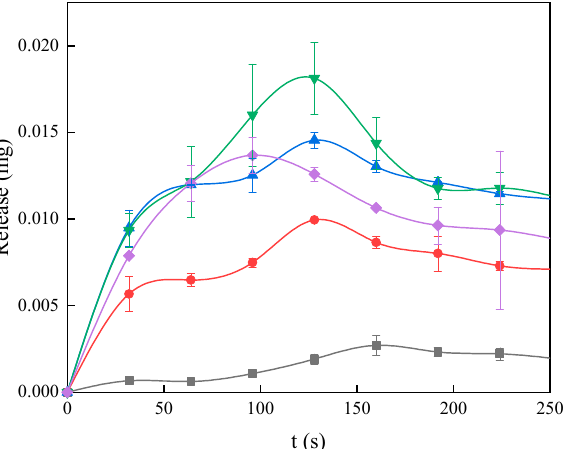
Figure 5. The time-laps release behavior of eugenol from tobacco leaf (the error bar represents the standard deviation of the measured value from three individual experiments).